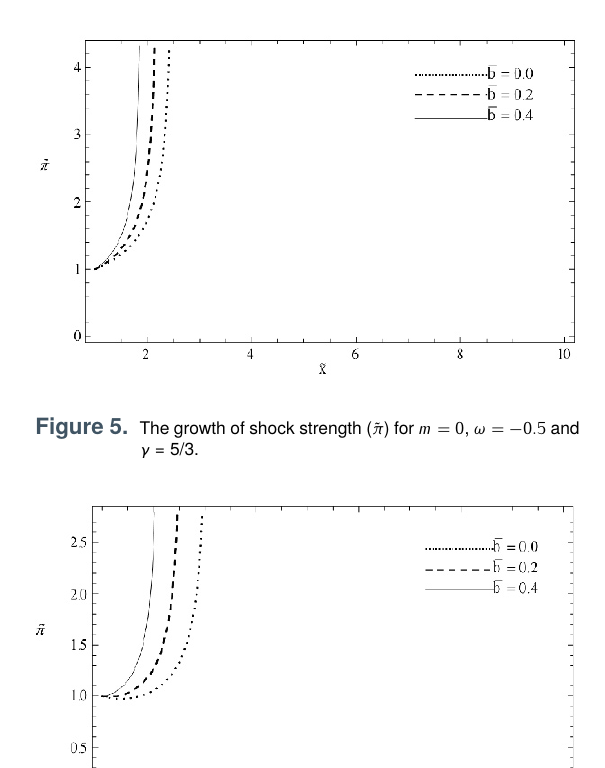
˜ π ) for m = 1 , ω = − 0 . 5 and